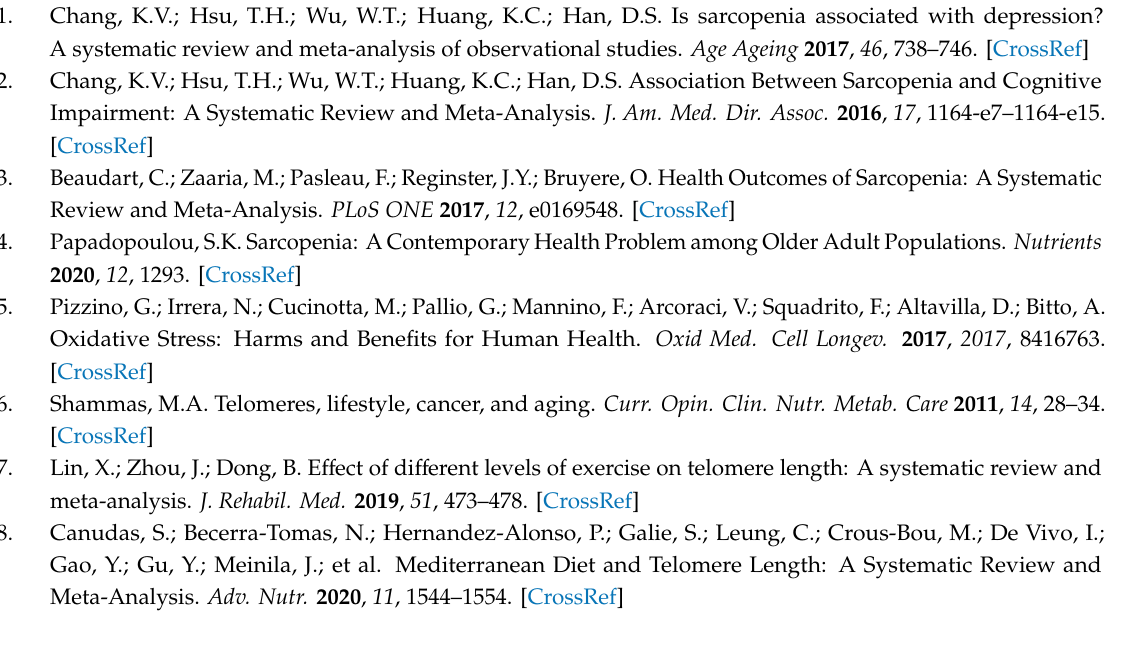
Table S1: List of the primers for